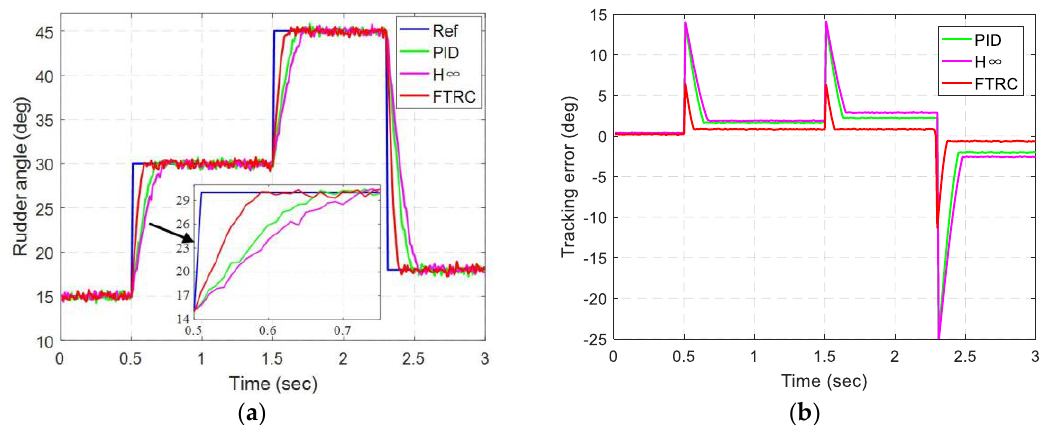
Figure 7. System response and error of different algorithms under input step signal: ( a ) system response; ( b ) system response error.